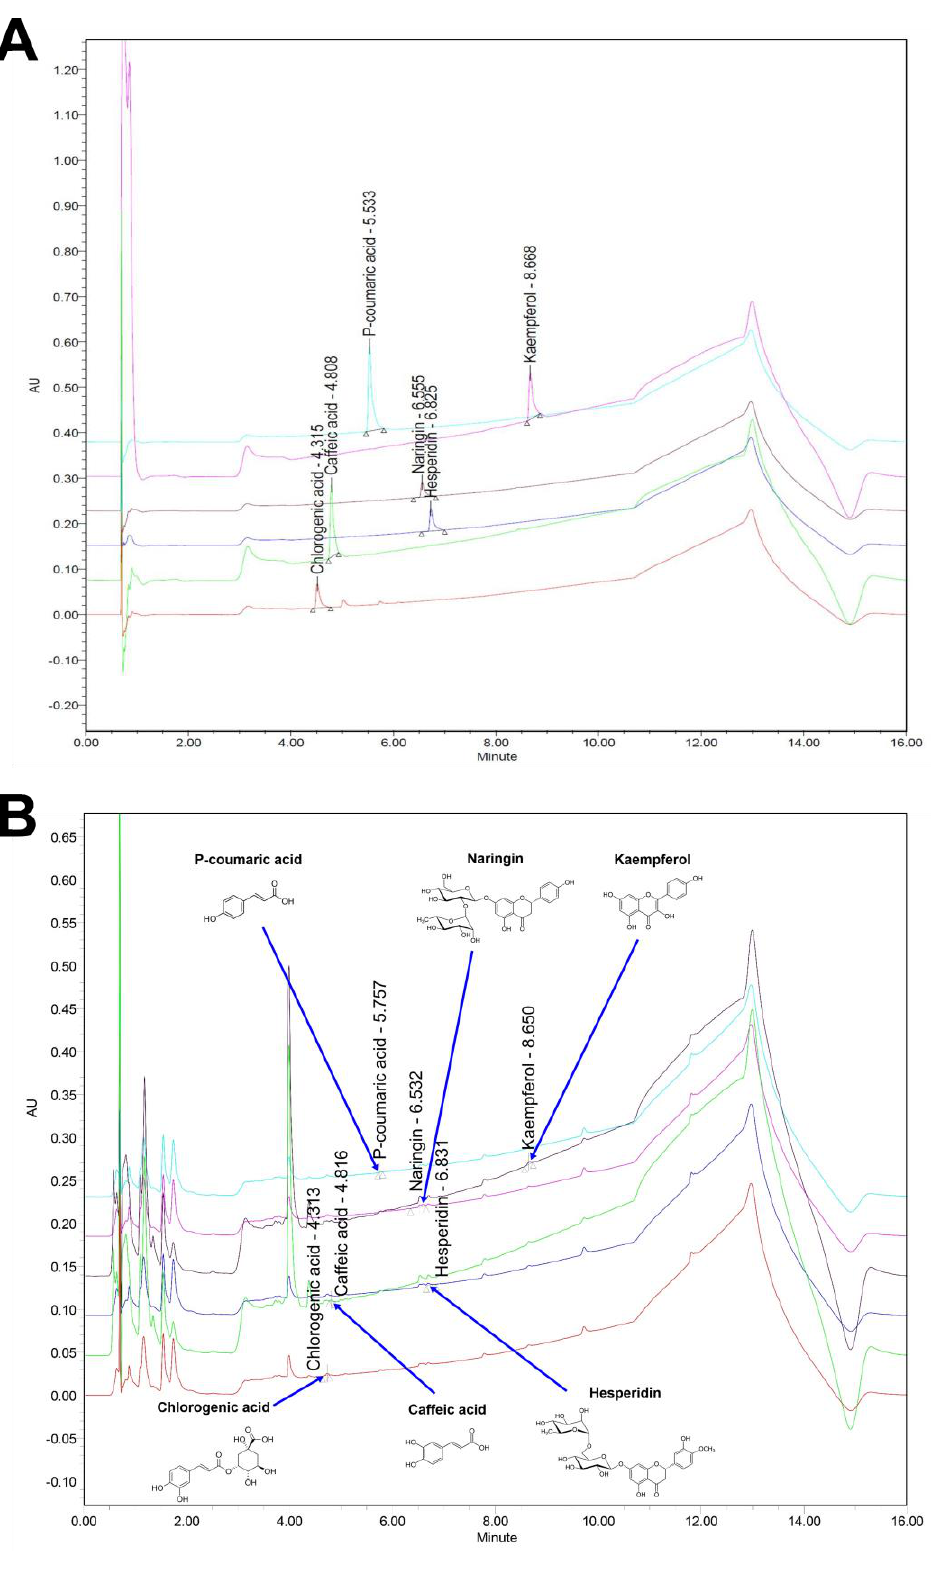
Figure 3. The GF contains flavonol and polyphenolic compounds responsible for its antioxidant properties. ( A ) UPLC profile of the internal standard compounds. ( B ) UPLC profile of six major compounds in GF. The insets indicate the chemical structures of naringin, hesperidin, p-coumaric acid, chlorogenic acid, kaempferol, and caffeic acid,